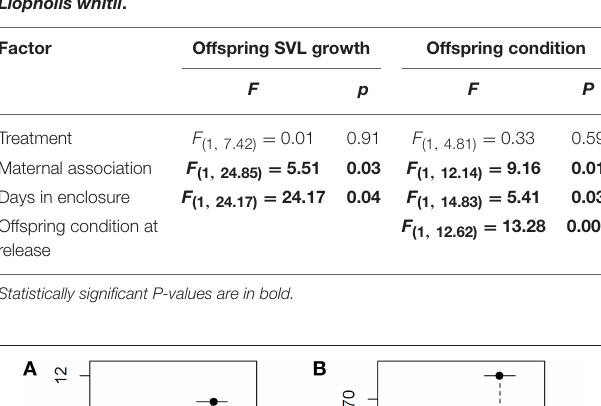
TABLE 2 | Output from models testing for effect of treatment and parent-offspring association on offspring growth and condition in Liopholis whitii .